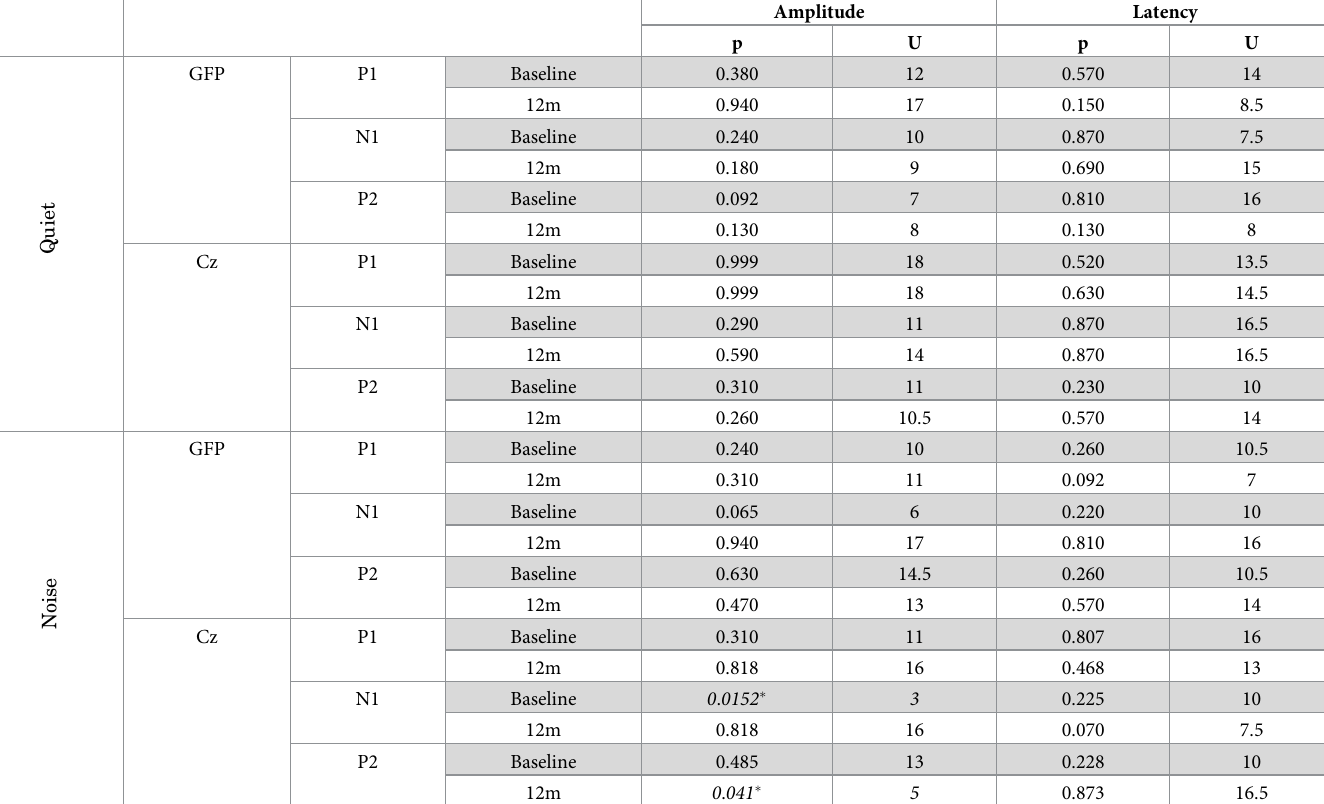
Table 4. Results of Mann-Whitney comparisons between the NH control group and SSD-CI participants at baseline or 12m for GFP and Cz responses in quiet and in noise.